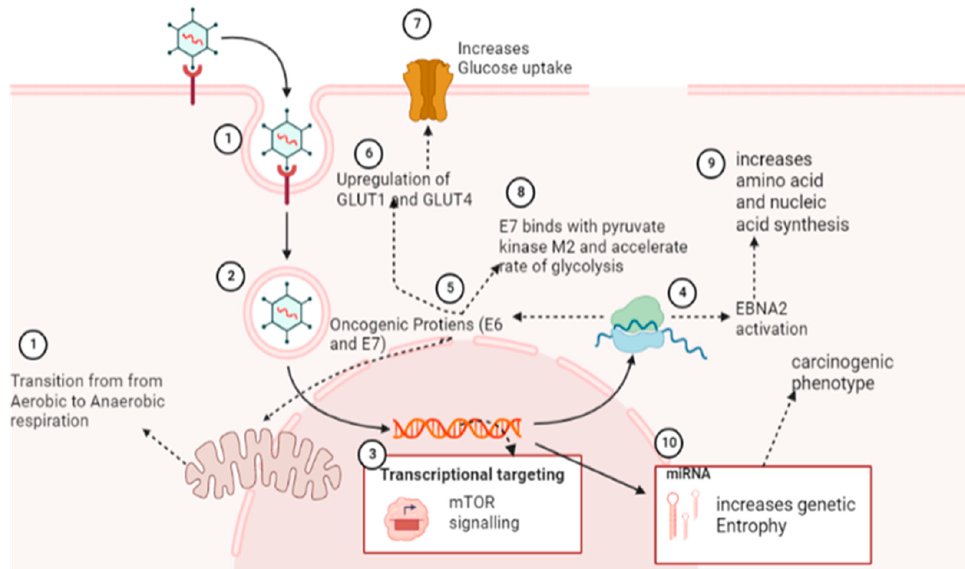
Figure 3. Transitions induced by oncogenic viruses in cellular metabolism make conditions favorable for virus and viral-induced cancer progression. This mechanism causes starvation of healthy cells under stressful conditions of the cancer microenvironment (Image created by biorender.com, accessed on 2 November 2022).